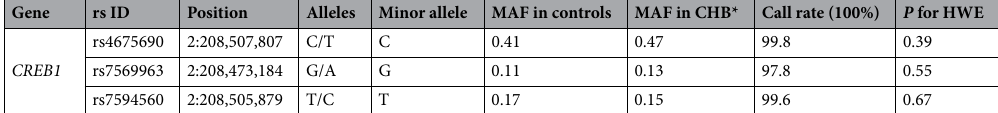
Table 2. Basic information of the SNPs in the current study. MAF minor allele frequency, CHB Han Chinese in Beijing, China, HWE Hardy–Weinberg equilibrium. *MAF was downloaded from the online database of 1000 Genomes for Han Chinese in Beijing, China. These three SNPs are not in the coding region of CREB1.